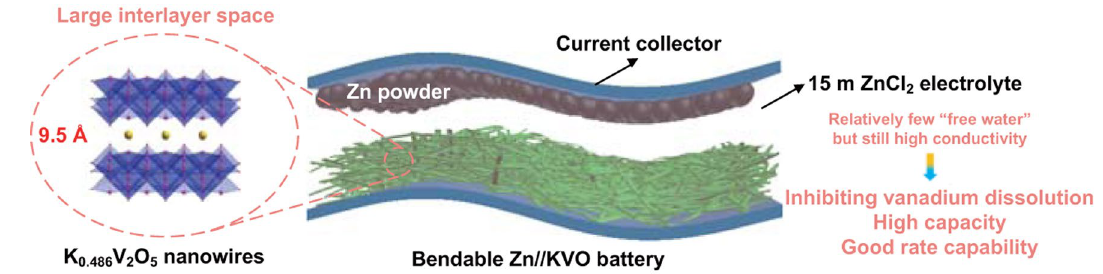
Fig. 1 Schematic illustration of bendable Zn//KVO cell with regulating electrolyte